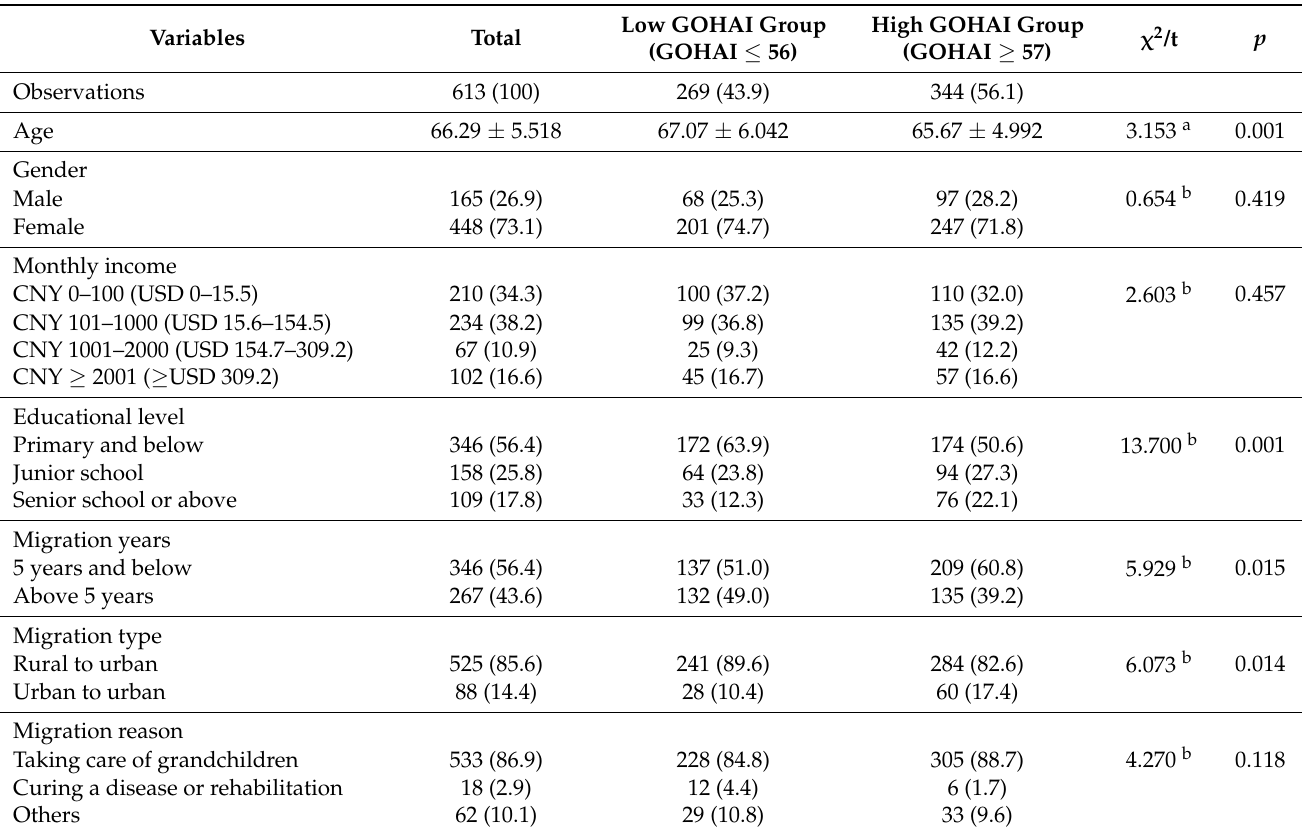
Table 1. Descriptive analysis of the demographic characteristics of the MEFC by GOHAI.